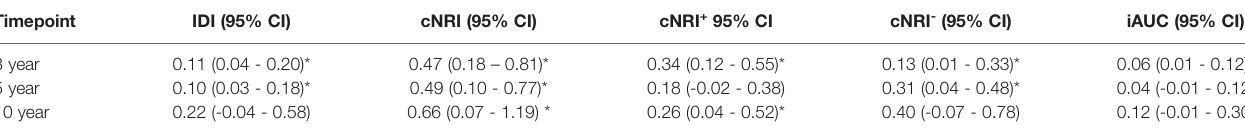
TABLE 2 | The predictive evaluation index for ERGs risk